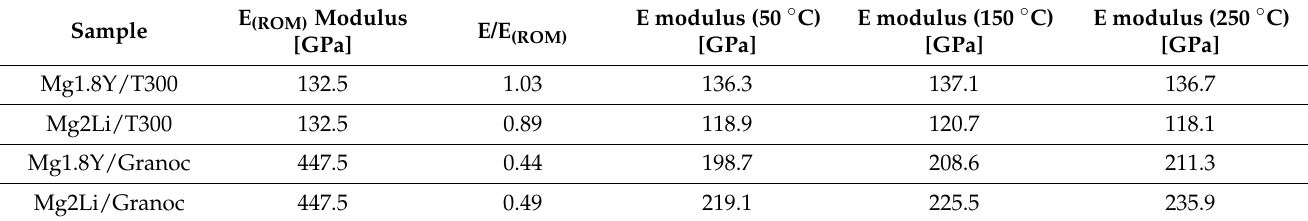
Figure 15. Complex modulus values of the composites with Granoc fibers.